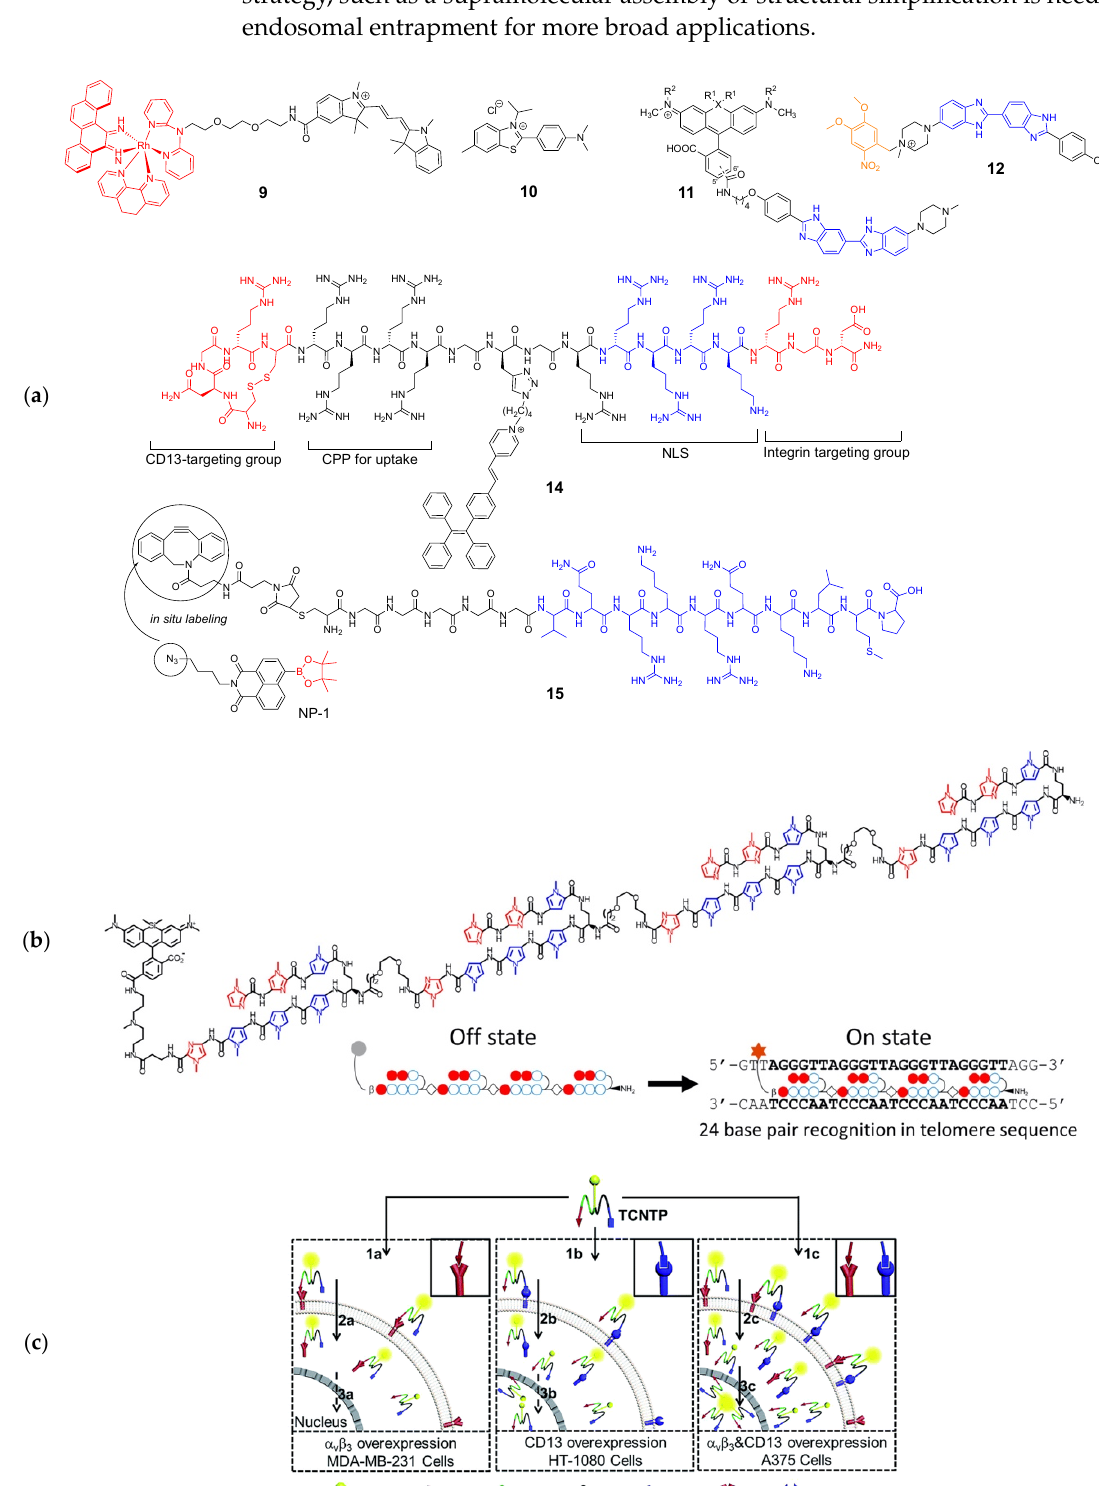
Figure 3. ( a ) Structures of nucleus-targeted probes (blue: targeting moiety; red: responsive moiety; orange: photocaging group); ( b ) Structure of 13 (SiR-TTet59B) and a schematic representation of fluorogenic recognition of the telomere sequence. Reprinted with permission from ref. [30]. Copyright 2020 American Chemical Society; ( c ) Schematic illustration of 14 targeting the nucleus of integrin α ν β 3 and CD13-overexpressed cancer cells. Reprinted with permission from ref. [31]—Published by The Royal Society of Chemistry.